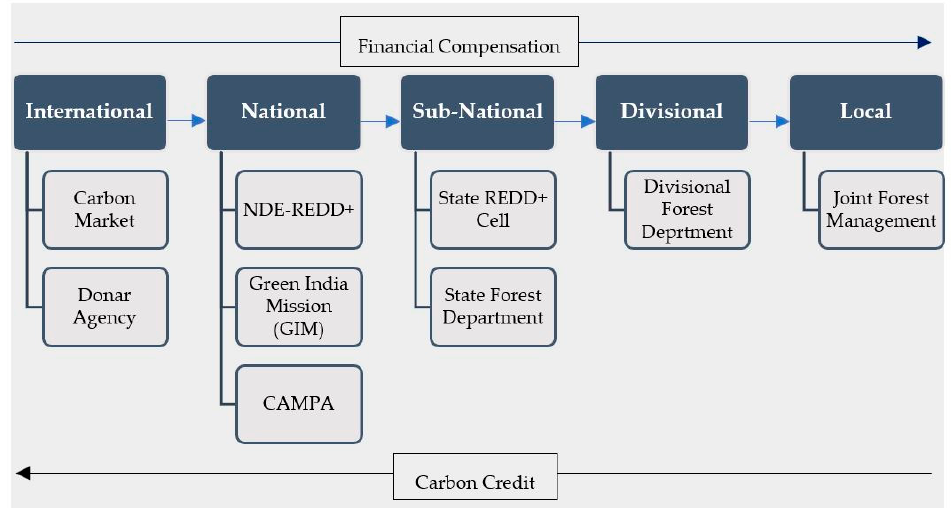
Figure 1. Institutional Structure of Benefit Sharing Mechanism under REDD+ in India. (Source: Au- thors, 2022) .